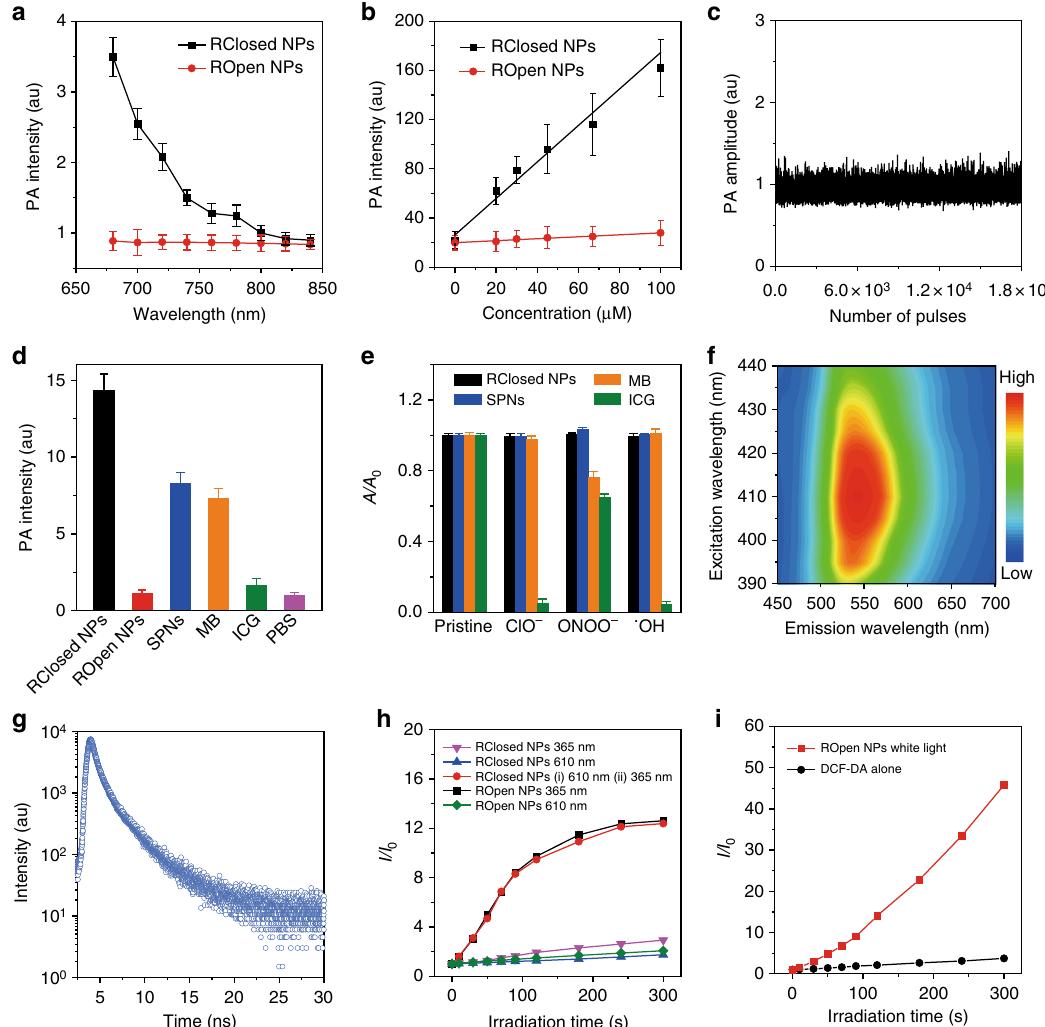
Fig. 4 In vitro PA, fl uorescence and ROS generation of the NPs. a PA spectra of RClosed and ROpen NPs. b PA intensities of RClosed and ROpen NPs at 700 nm as a function of molar concentration based on DTE-TPECM molecules. Error bars, mean ± s.d. ( n = 3) for a , b . c PA amplitudes of RClosed NPs as a function of number of laser pulses (1.8 × 10 4 pulses; 1.5 W cm − 2 laser and 20 Hz pulse repetition rate). d PA intensities excited with 680 nm pulsed laser of various agents at the same molar concentration (100 μ M) based on MB, ICG, DTE-TPECM molecules and the repeat unit of SP. e Plot of A / A 0 versus different RONS. A and A 0 are the absorption intensity at 680 nm of RClosed NPs, SPNs, MB and ICG in the presence and absence of RONS (400 μ M), respectively. Error bars, mean ± s.d. ( n = 3) for ( d , e ). f PL excitation mapping and g fl uorescence decay curve of ROpen NPs. h Plot of I / I 0 versus light irradiation time. The aqueous solution of RClosed NPs or ROpen NPs (10 μ M based on DTE-TPECM) was exposed to 610 nm red light (0.3 W cm − 2 ) and/ or 365 nm UV light (0.1 W cm − 2 ). i Plot of I / I 0 versus white light (0.25 W cm − 2 ) irradiation time of ROpen NPs (10 μ M based on ROpen-DTE-TPECM) in aqueous solution. I 0 and I are the PL intensity of DCF at 525 nm before and after light irradiation at designated time intervals in both h ,